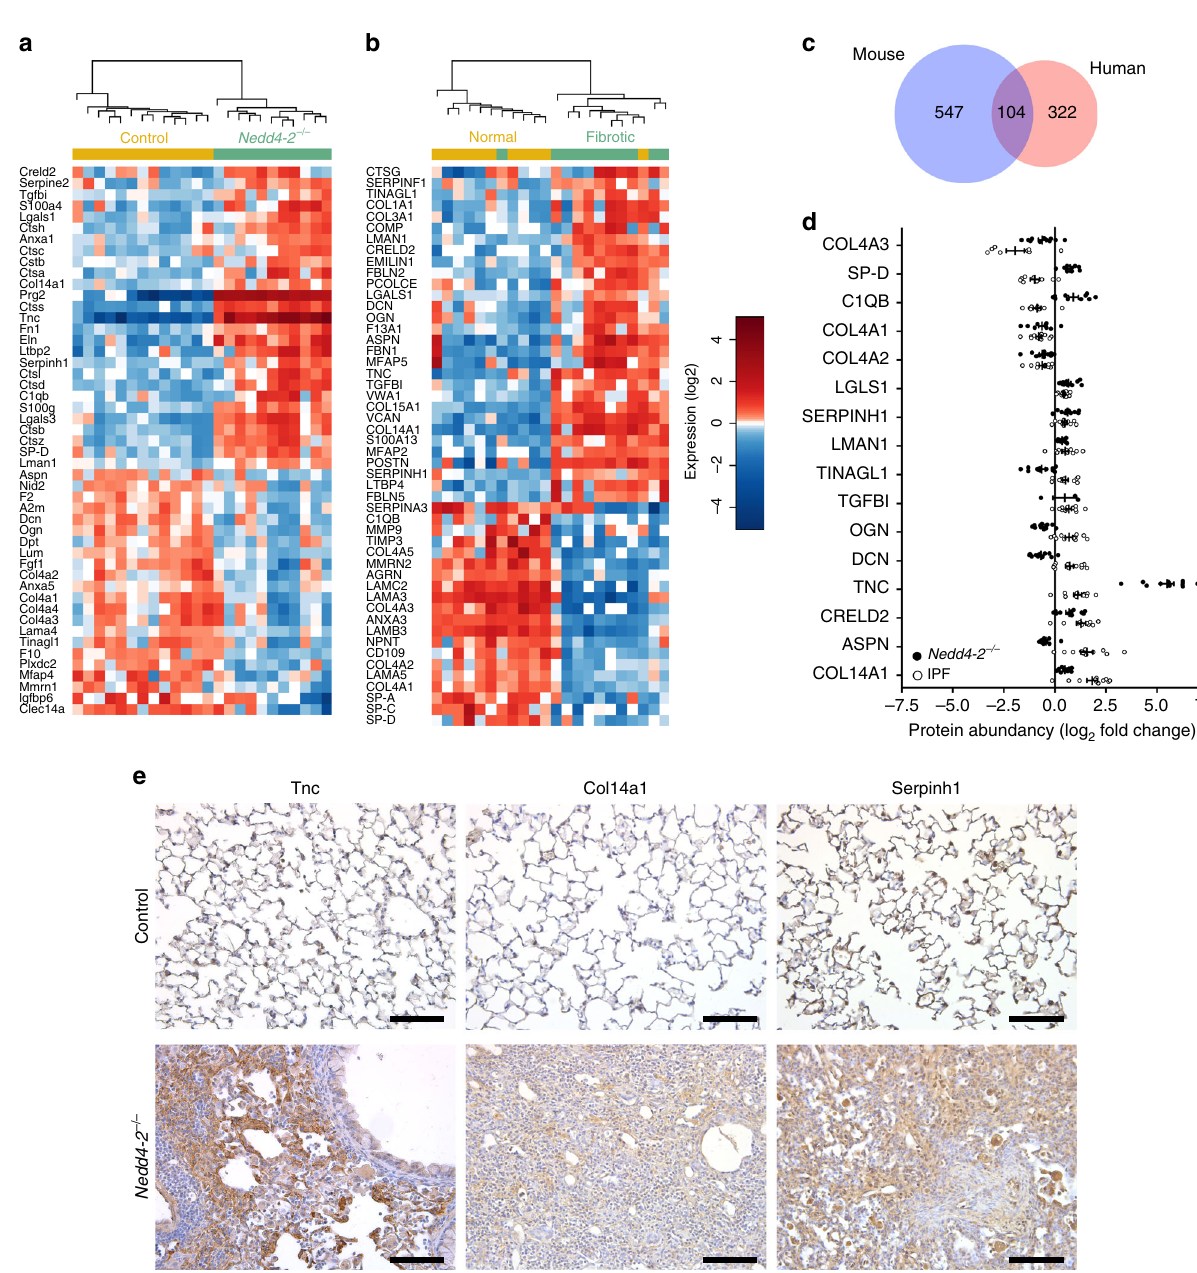
Fig. 7 Comparison of proteomic signatures of pulmonary fi brosis in conditional Nedd4-2 − / − mice and patients with IPF. a , b Heatmap of differentially regulated matrisome annotated proteins in lungs from conditional Nedd4-2 − / − mice ( n = 11) and control mice ( n = 13) induced with doxycycline for 3 months ( a ), and in lung tissues from IPF patients and controls ( n = 11/group) ( b ). c Venn-diagram showing proportion of unique and common differentially regulated proteins in lungs of conditional Nedd4-2 − / − mice and IPF patients. d Summary of differentially regulated matrisome proteins found in conditional Nedd4-2 − / − mice and human IPF samples. e Micrographs of representative lung sections from conditional Nedd4-2 − / − mice and littermate controls stained with anti-Tnc, anti-Col14a1, and anti-Serpinh1 antibodies ( n = 6/group). Scale bars, 100 µ